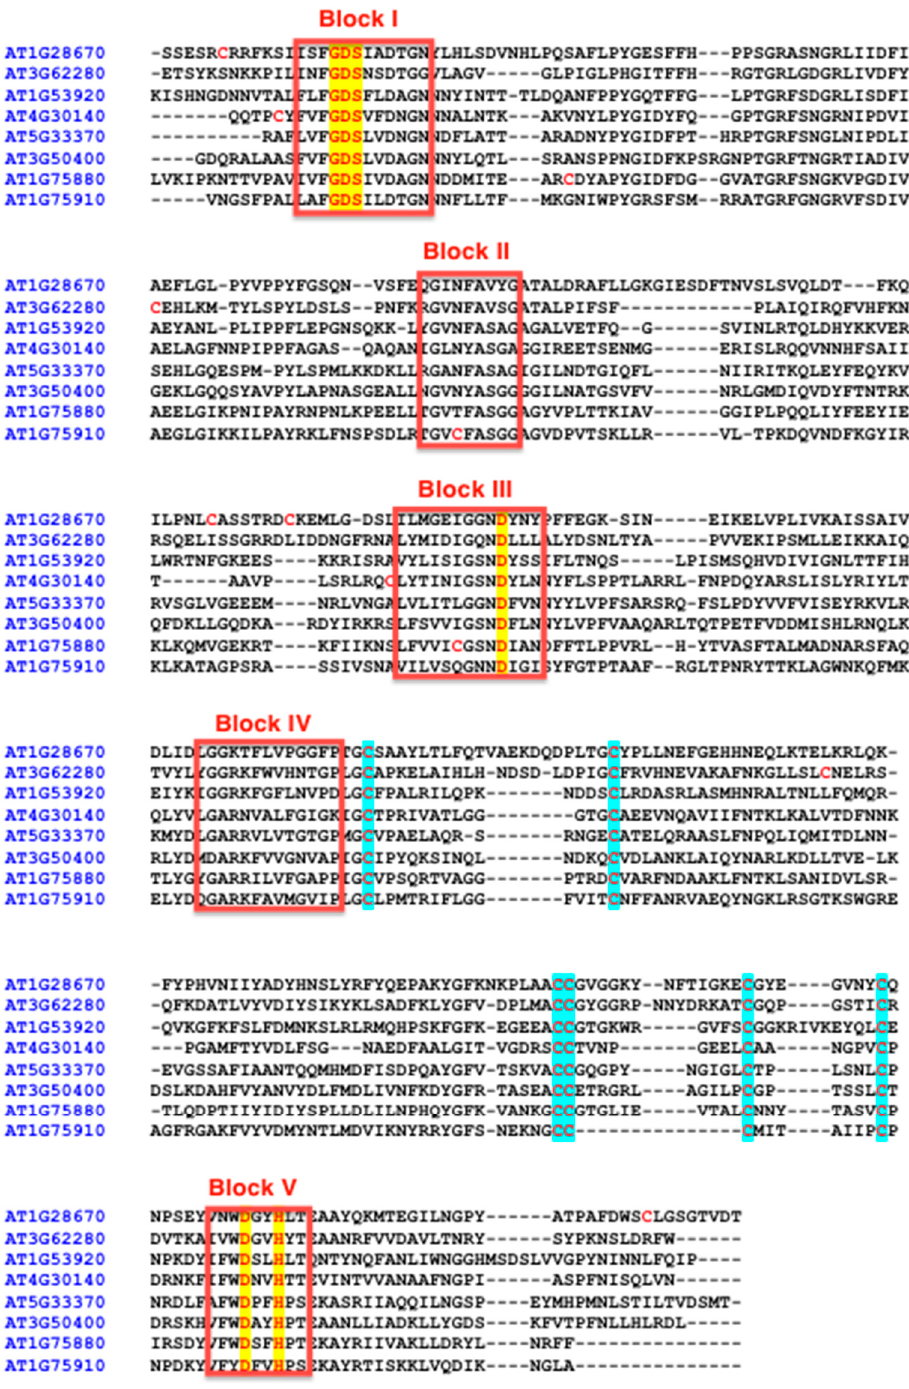
Figure 2. Amino acid sequences of Arabidopsis GDSL-lipases. A representative of the different clades (see last figure in the manuscript) was chosen for sequence alignment. The conserved residues involved in catalysis are highlighted in yellow while the cysteines of the six cysteine motifs (see text) are highlighted in blue. Other non-conserved cysteines are highlighted in red.